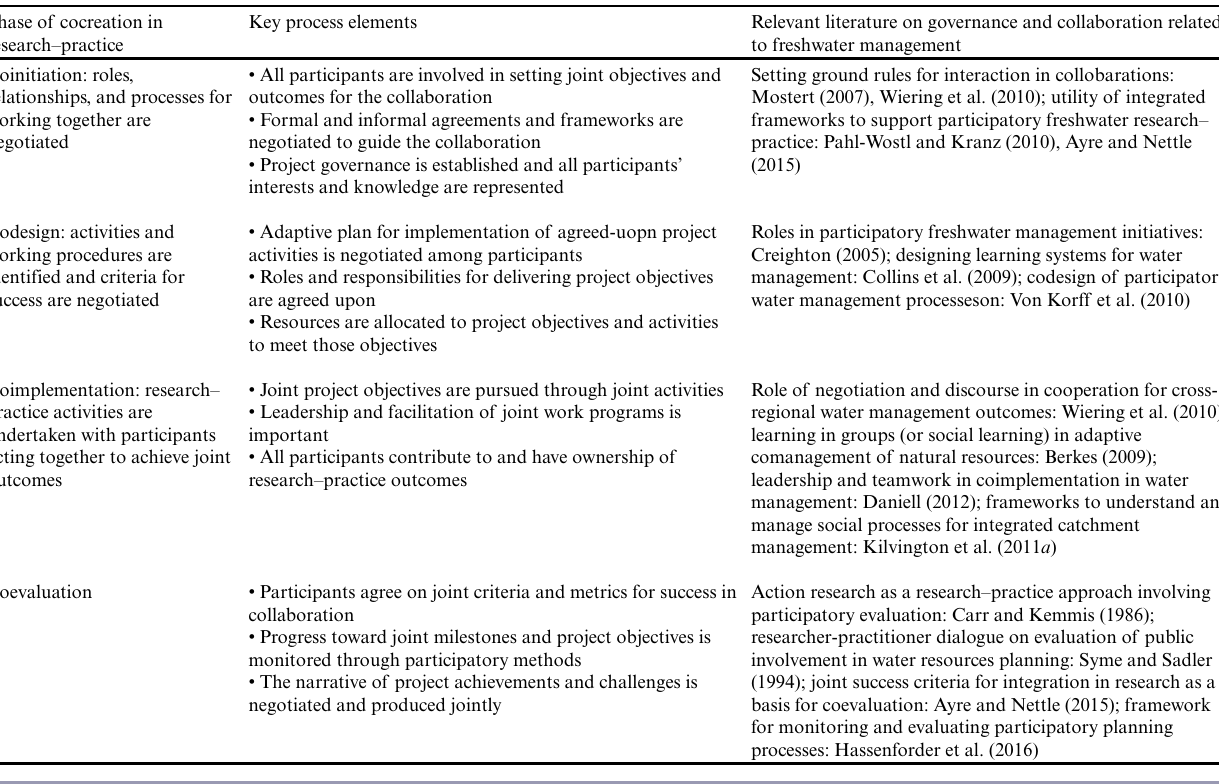
Table 1. Analytical framework for cocreation in research–practice for freshwater governance and